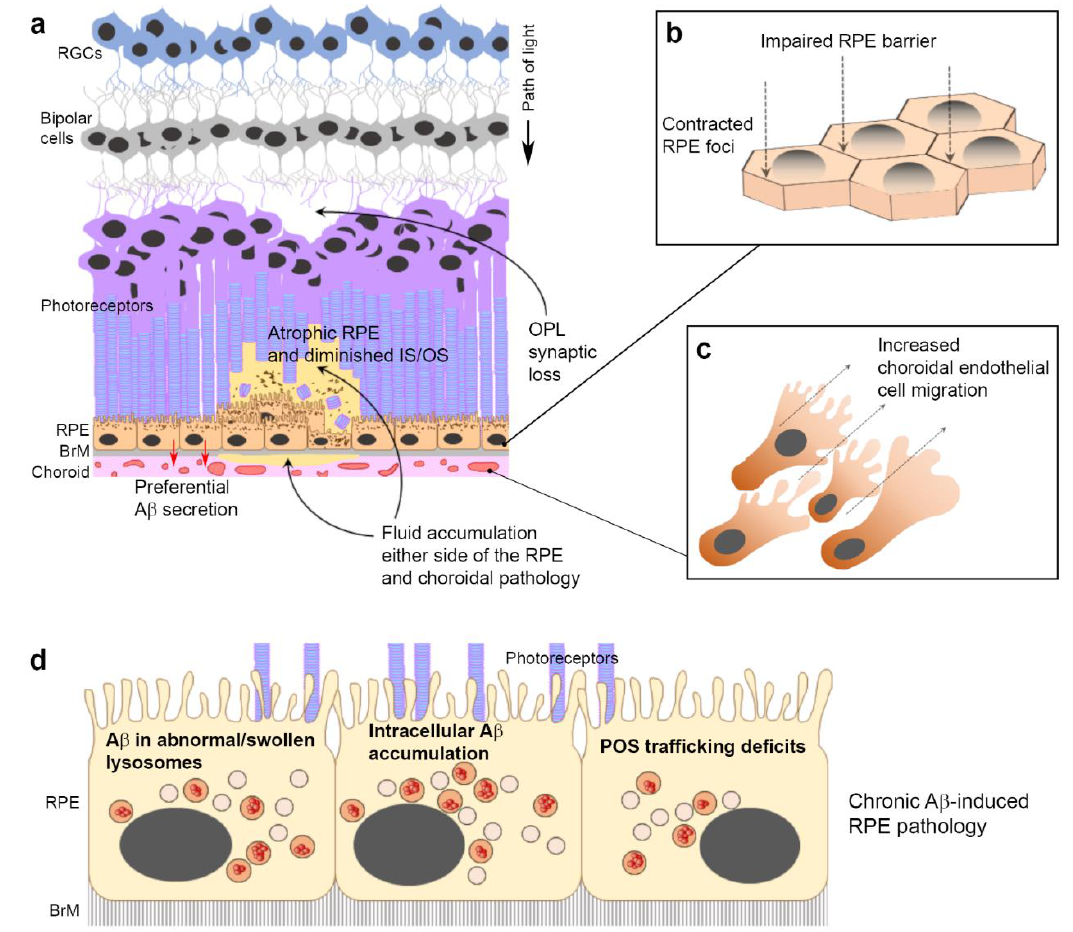
Figure 9. Summary diagram of Aβ-induced pathology in the retina. The age-related Aβ accumulation reported in sub- RPE/drusen, POS and choroid of donor AMD tissues and in animal models is recapitulated by Aβ-injected mice and by in vitro studies. ( a ) Development of localized retinal pathology with GA-like features alongside synaptic loss in the OPL following subretinal Aβ injection in living mouse eyes. ( b ) Impaired RPE barrier with development of contracted RPE foci following exposure to human oligomeric Aβ 1-42 . ( c ) Choroidal pathology in the form of increased endothelial cell migration after Aβ exposure. Aβ effects appear to be mediated directly rather than via upregulation of VEGF. ( d ) Aβ is internalized by RPE lysosomes, which become swollen. An insufficient lysosomal cathepsin B response contributes to Aβ accumulating in RPE lysosomes. RPE exposed to oligomeric Aβ exhibit lysosomal deficits affecting the capacity to traffic/degrade POS cargos, which over time, could contribute to developing visual defects.